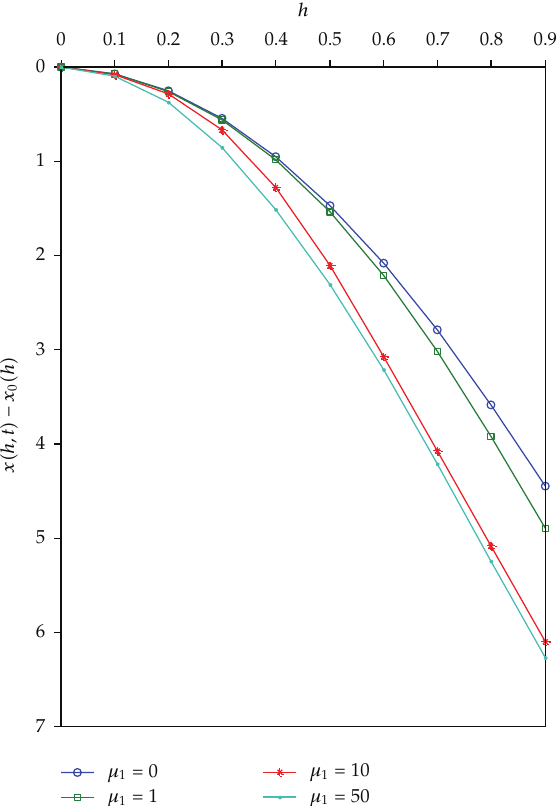
Figure 6: The e ff ect of the material parameter μ 1 on the drainage rate for S 1 (cid:8) 2, S 2 (cid:8) 1 for impermeable